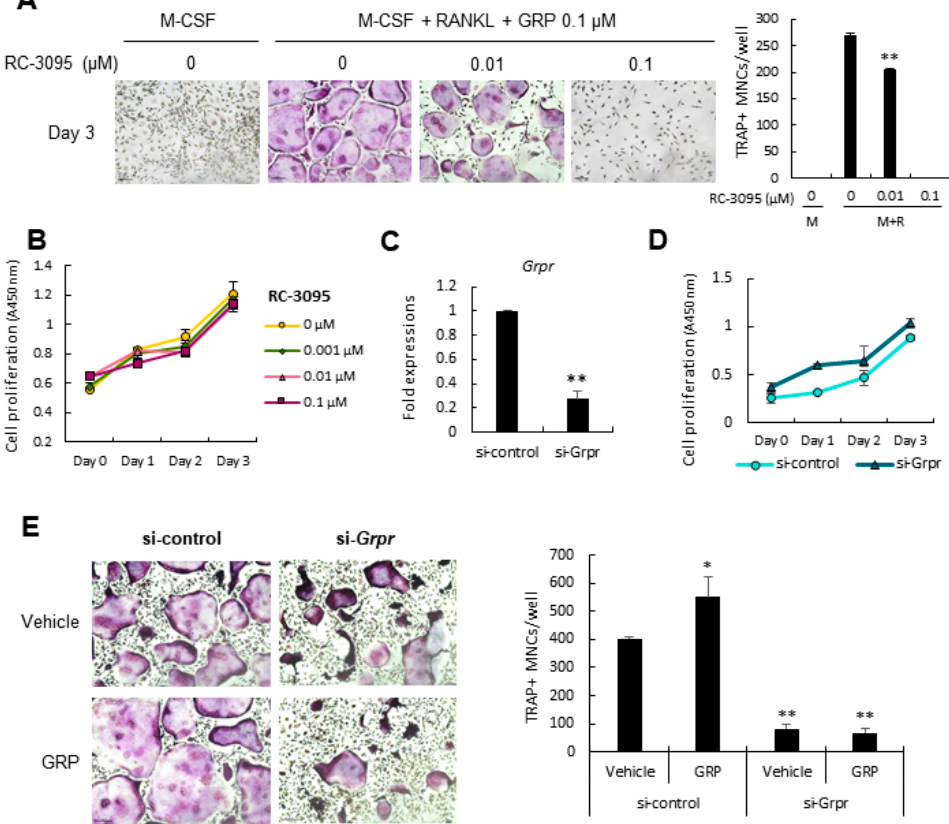
Figure 2. Antagonizing or silencing Grpr abolishes the pro-osteoclastogenic effect of GRP. ( A ) BMMs were cultured with increasing concentrations of gastrin-releasing peptide receptor (GRPR) antagonist RC-3095. The number of TRAP+ MNCs were quantified on Day 3; ( B ) CCK-8 assay showed that RC-3095 did not affect BMMs proliferation; ( C ) The efficiency (~70%) of Grpr gene knockdown in BMMs using siRNA transfection was confirmed by quantitative PCR; ( D ) CCK-8 assay showed that there are no significant differences in the proliferation of BMMs between si-control and si- Grpr ; ( E ) On Day 8, a significant decrease in osteoclastogenesis is observed in the si- Grpr group as compared with the si-control group. Scale bars, 100 µ m. Magnification, × 100. Quantitative data are presented as mean ± SD. * p < 0.05 and ** p < 0.01 by ANOVA test. Asterisk shows a significant difference from the control or vehicle group.